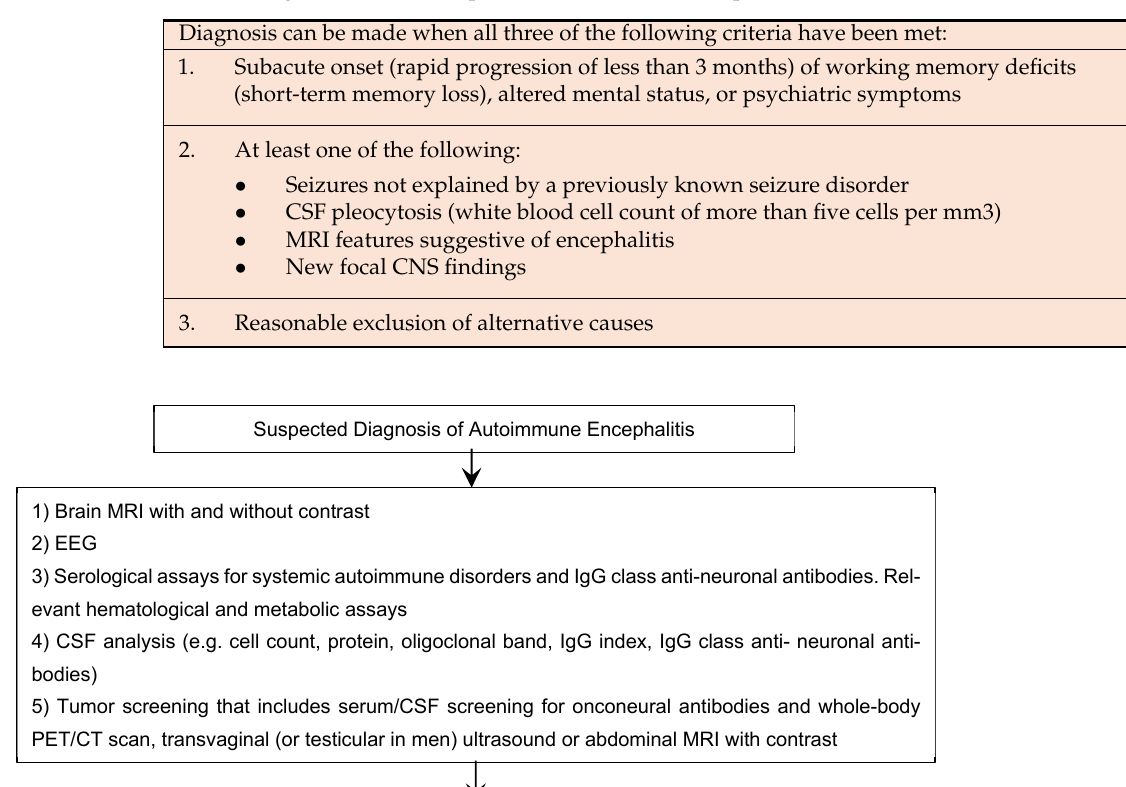
Table 3. Diagnostic criteria for possible autoimmune encephalitis.